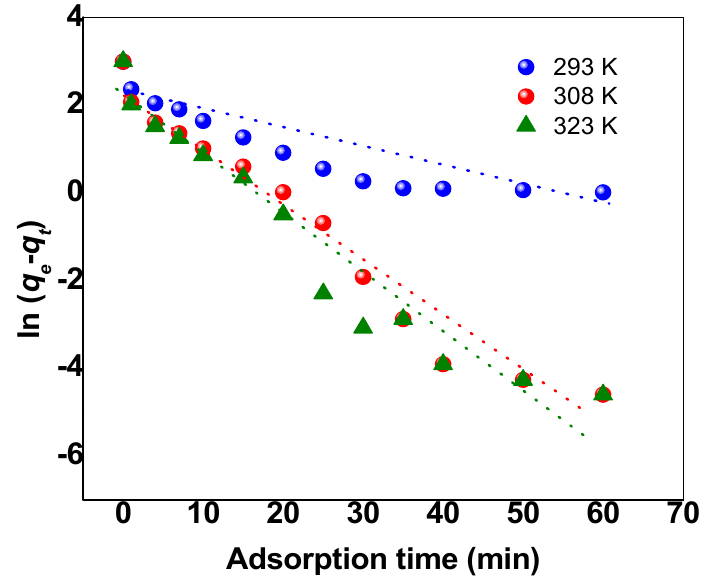
Figure 9. The application of the pseudo-first-order kinetic model for the MB dye removed from an aqueous solution by SNCM.